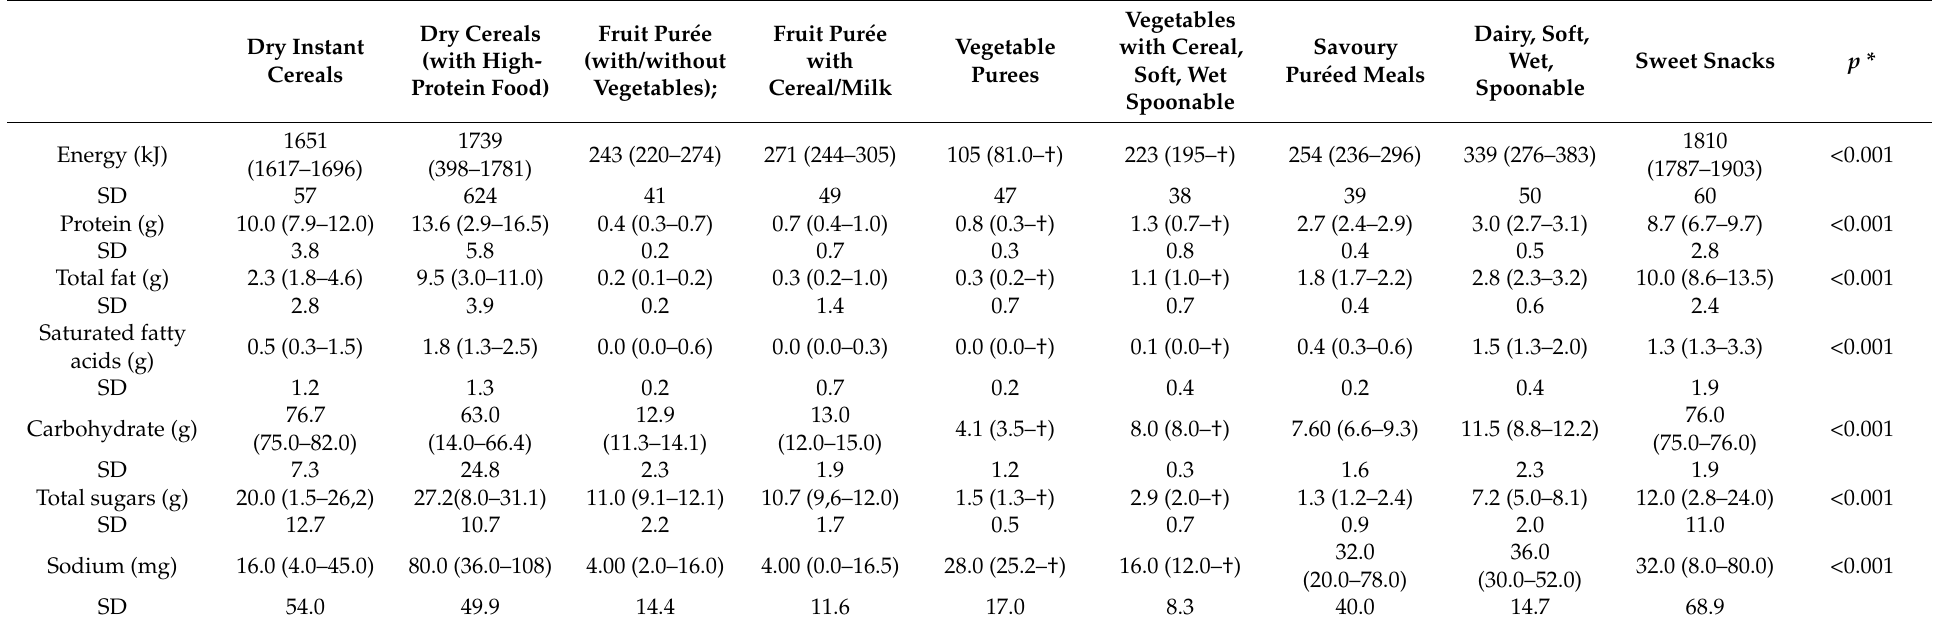
Table 2. Nutritional composition per 100 g for CACFs by food category, considered in the